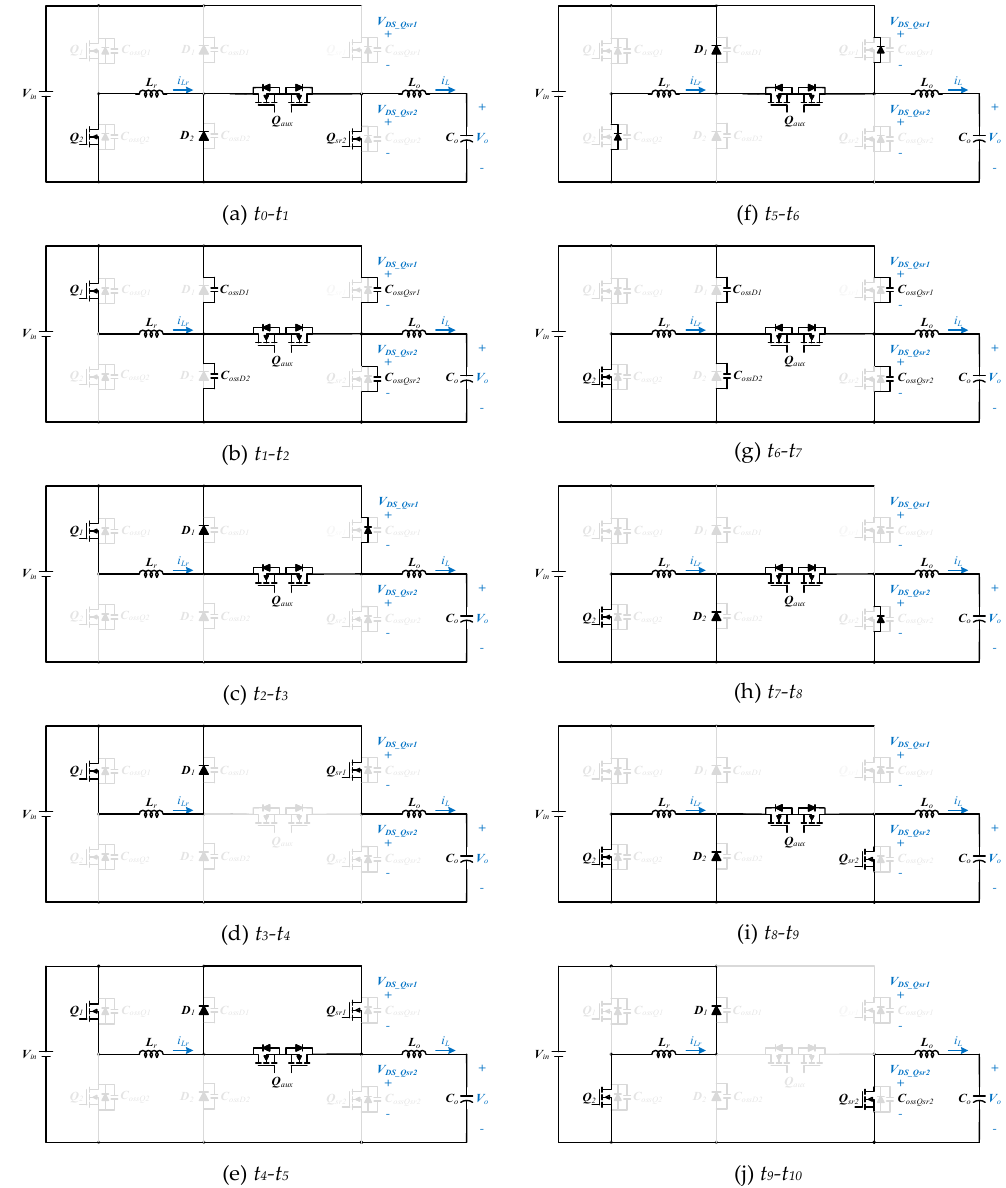
Figure 9. Topology operation intervals of the proposed converter.